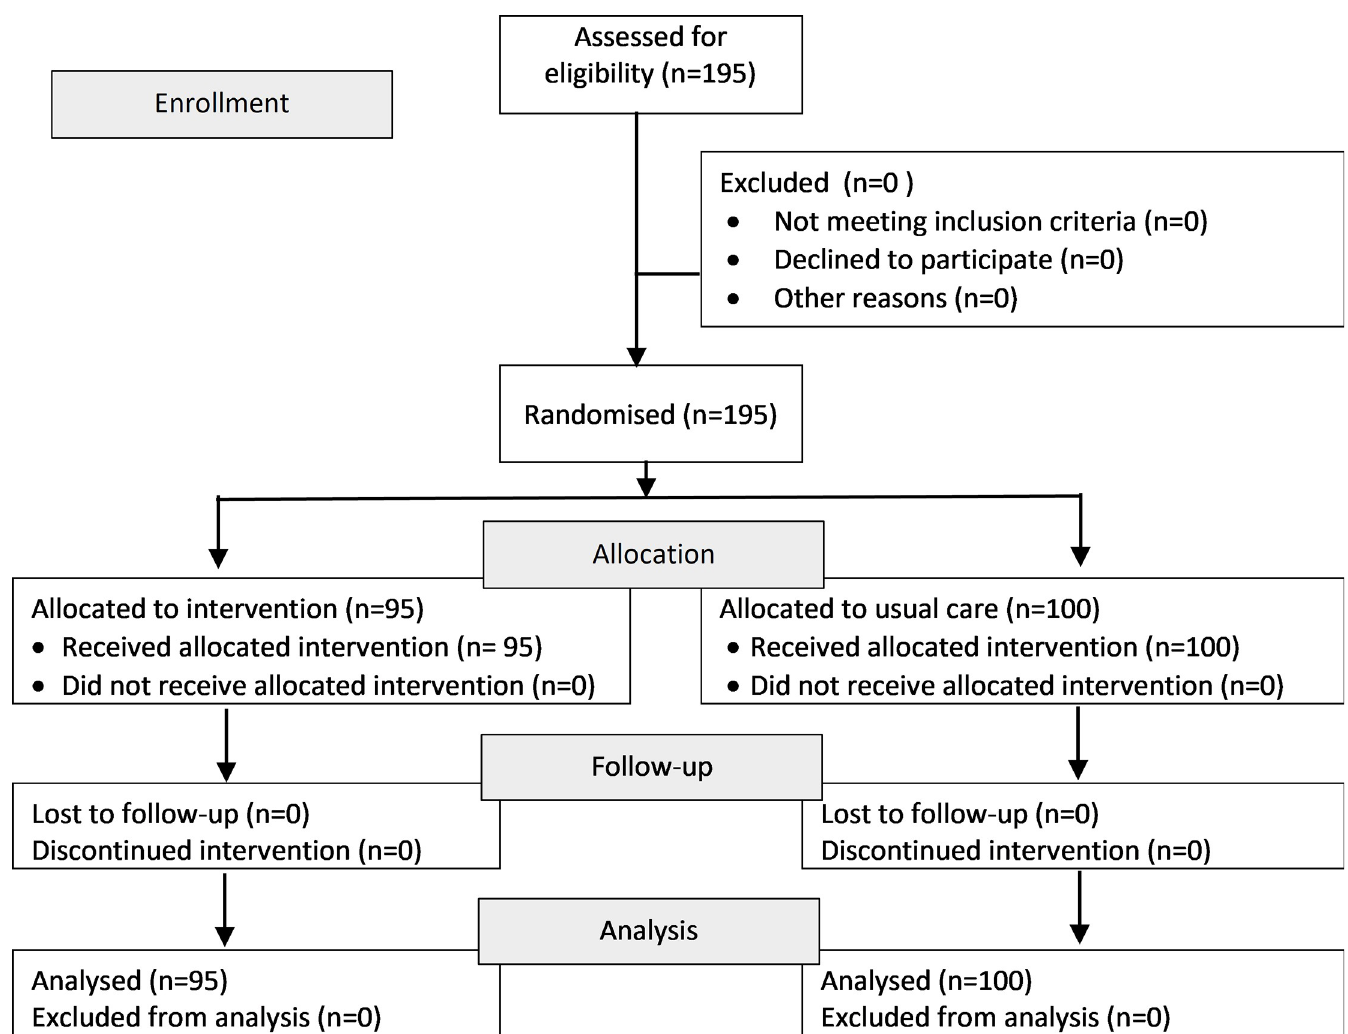
Fig 2. CONSORT flow diagram for phone calls trial